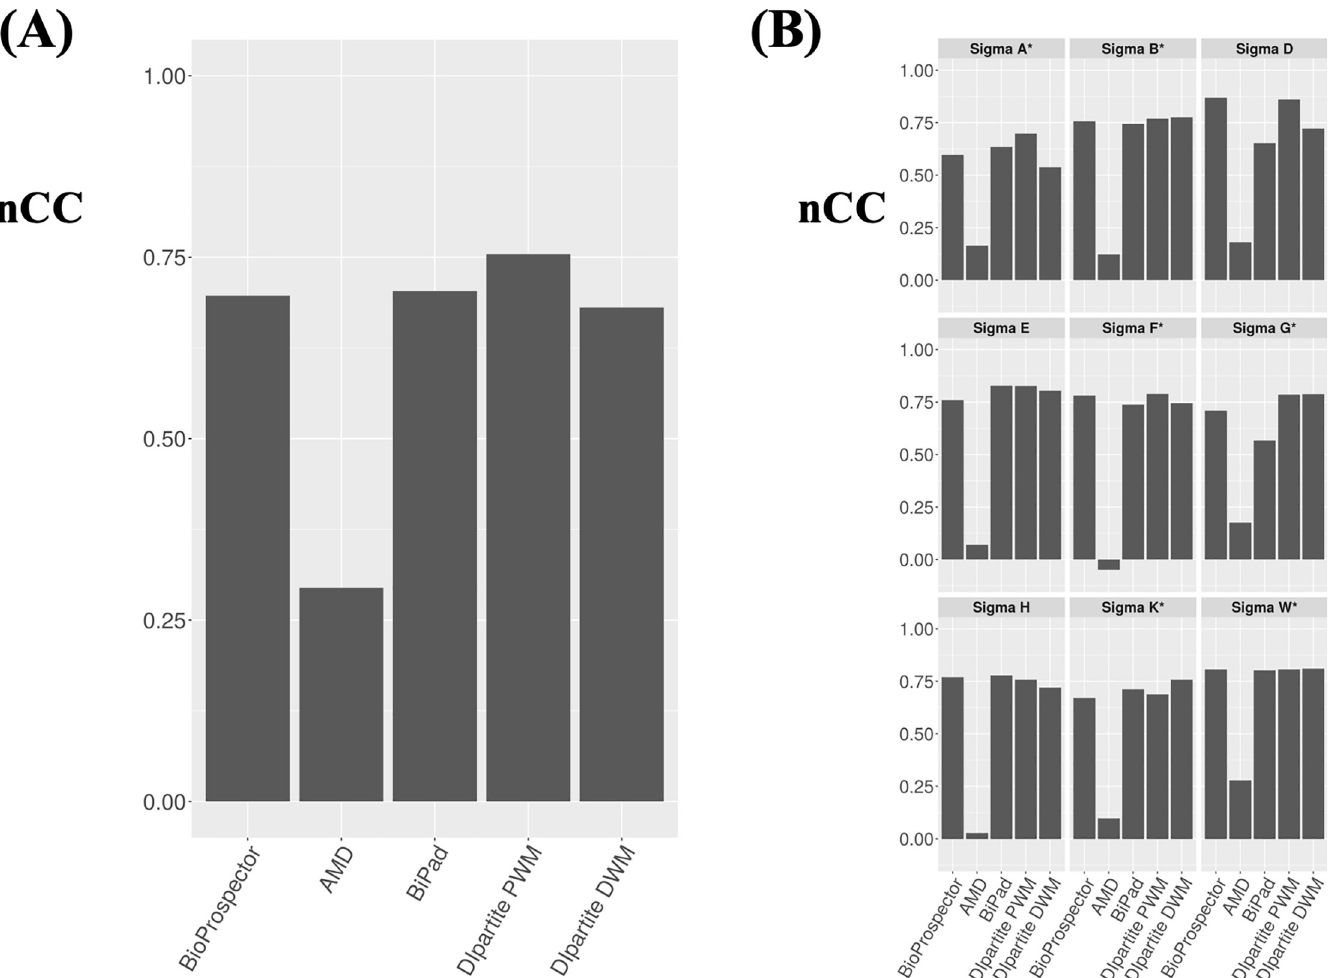
Fig 4. The performance comparison for B . subtilis datasets. (A) Summary of the results of all sigma datasets. (B) Summary of the results of each sigma datasets. σ A , σ B , σ D , σ E , σ F , σ G , σ H , σ K , and σ W consist of 344, 64, 30, 70, 25, 55, 25, 53, and 34 sequences, respectively. The asterisks indicate if DIpartite performed better than BioProspector, AMD, and